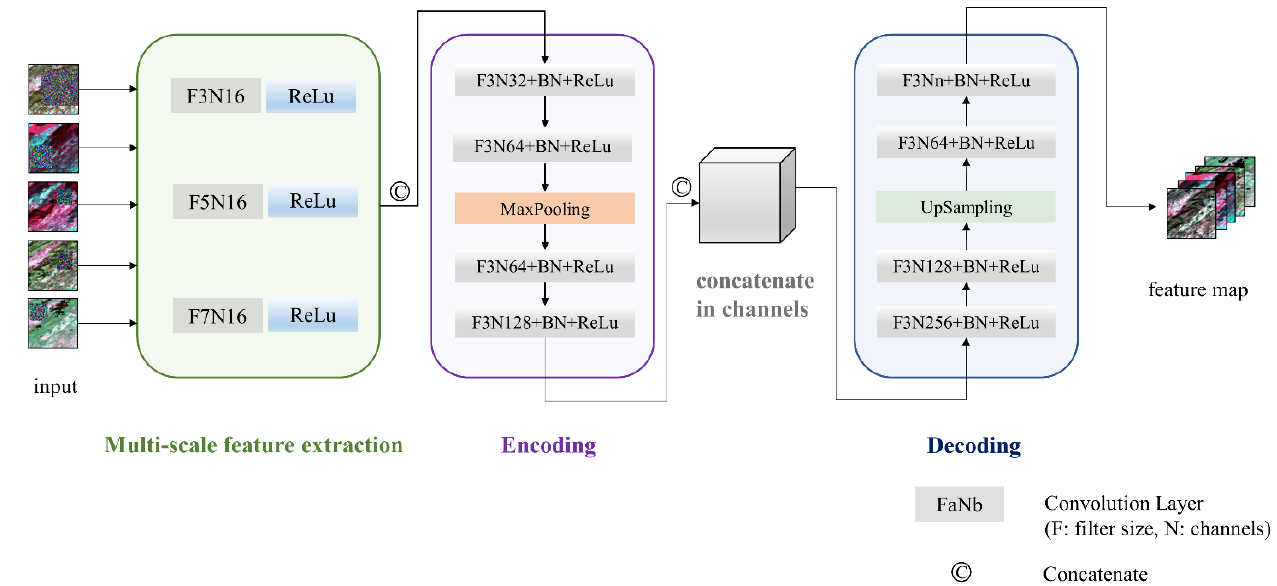
Figure 3. The structure of the content generation network proposed in this study.